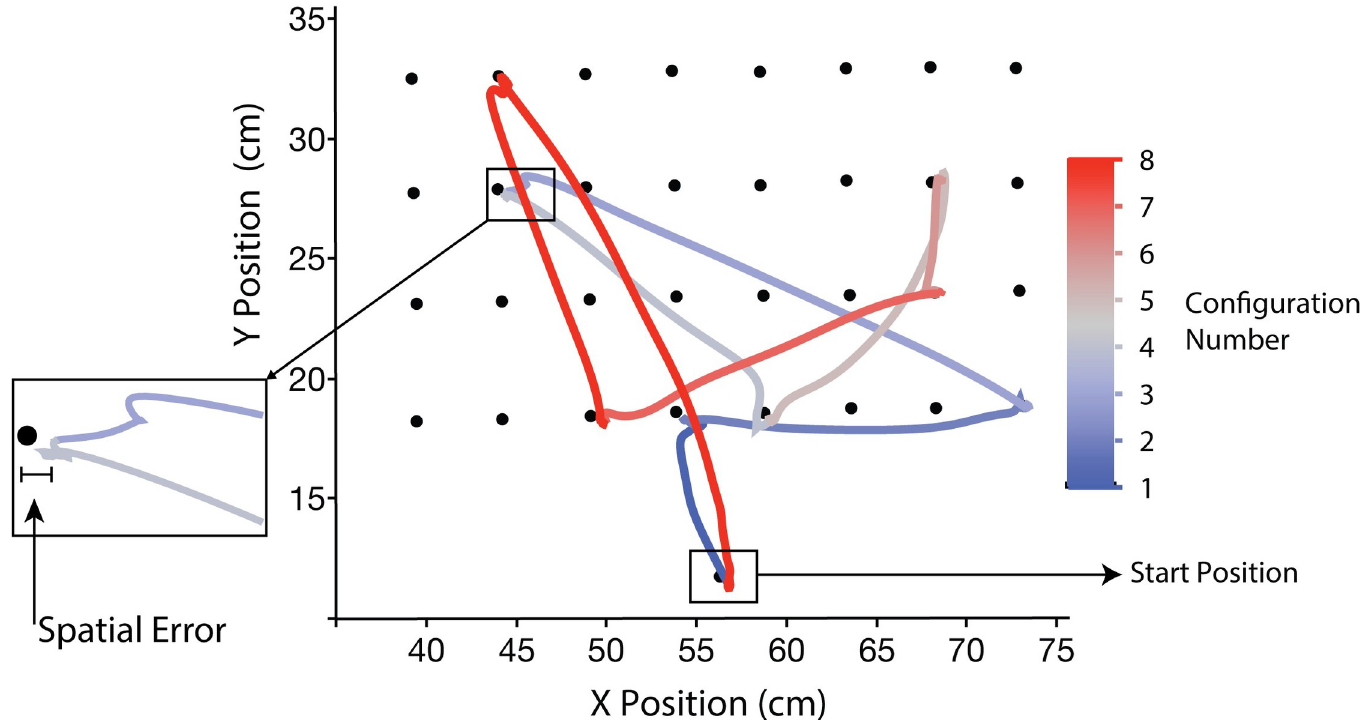
Fig 4. Example trajectories of participant’s movements in a joint-action phase. The figure shows the kinematic data of a participant across all eight targets of a movement sequence. Spatial error marks the distance between the target position that participants were supposed to hit and where they hit at the end of each trajectory which is referred to as landing